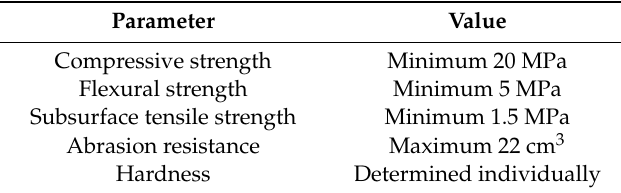
Table 1. The list of chosen strengths and functional parameters for floors.